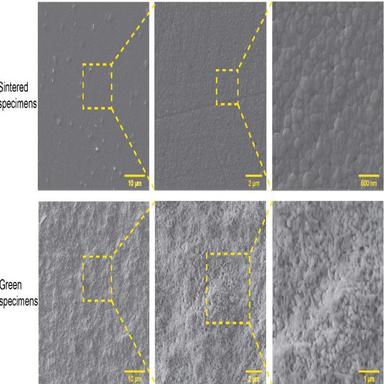
SEM morphology of polished and thermal etched fracture surfaces of 3D printed green and sintered zirconia specimens under different magnifications.